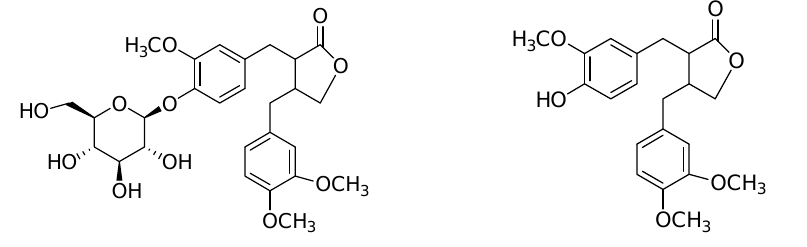
Figure 1. Chemical formula of arctiin Figure 2. Chemical formula of